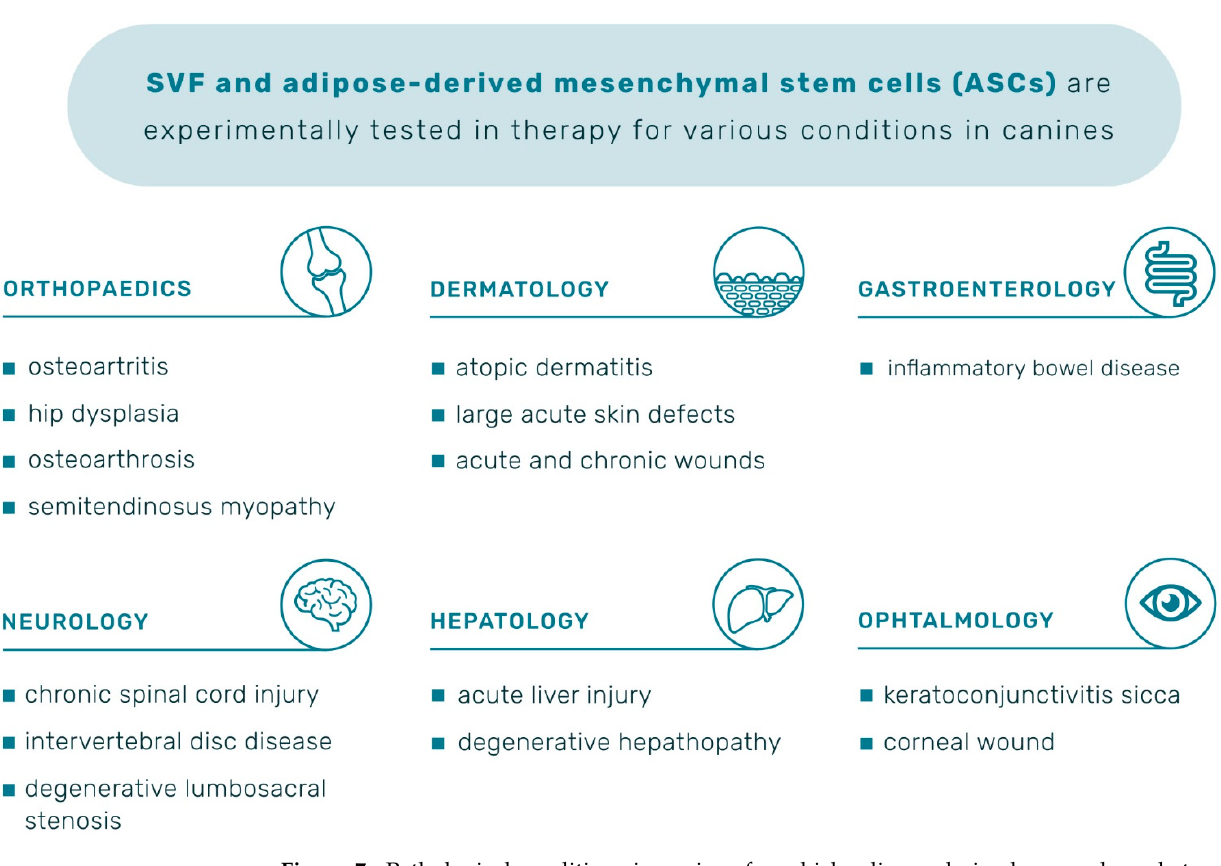
Figure 7. Pathological conditions in canines for which adipose-derived mesenchymal stem cell therapy was applied.